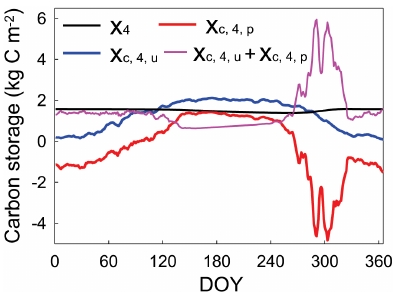
Figure 4. Components of the C storage capacity for litter pool (i.e., pool 4 as shown in Fig. 1). Component x c , 4 ,u (t) is the C from C in- put and component x c , 4 , p (t) is the C moved from all the other pools to the litter pool. The sum of them is the attractor that determines the direction of C storage change in pool 4.